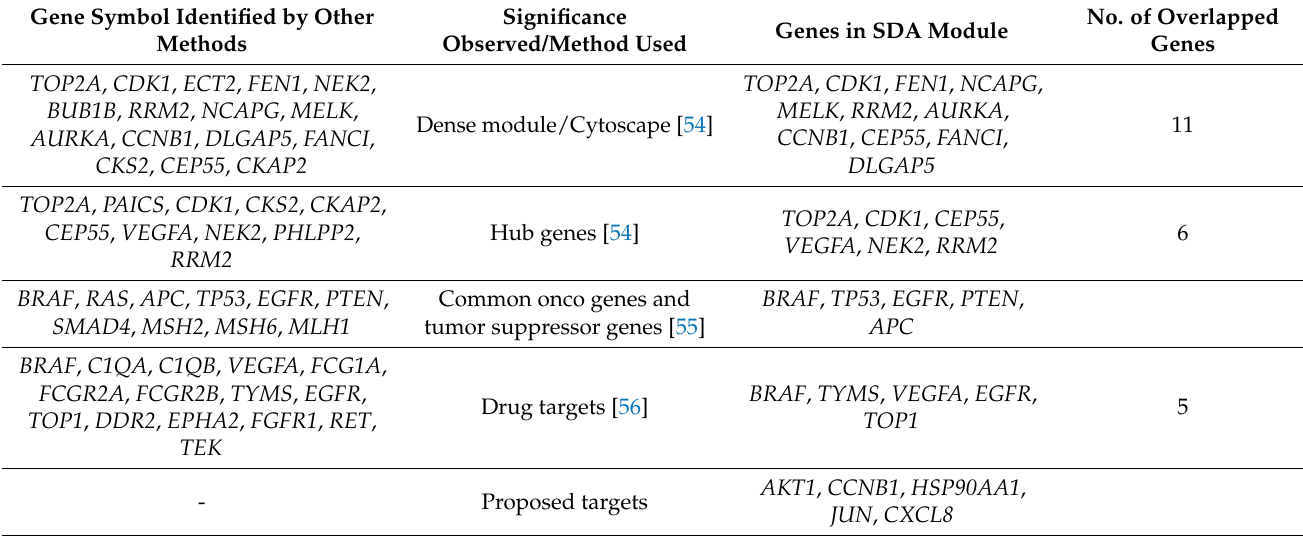
Figure 7. The optimum dys-regulated subnetwork generated by the SDA algorithm for CRC. The yellow nodes represent genes with low weights in the module and top-weighted nodes are purple. Table 5. Module gene associations with diseases for the CRC gene